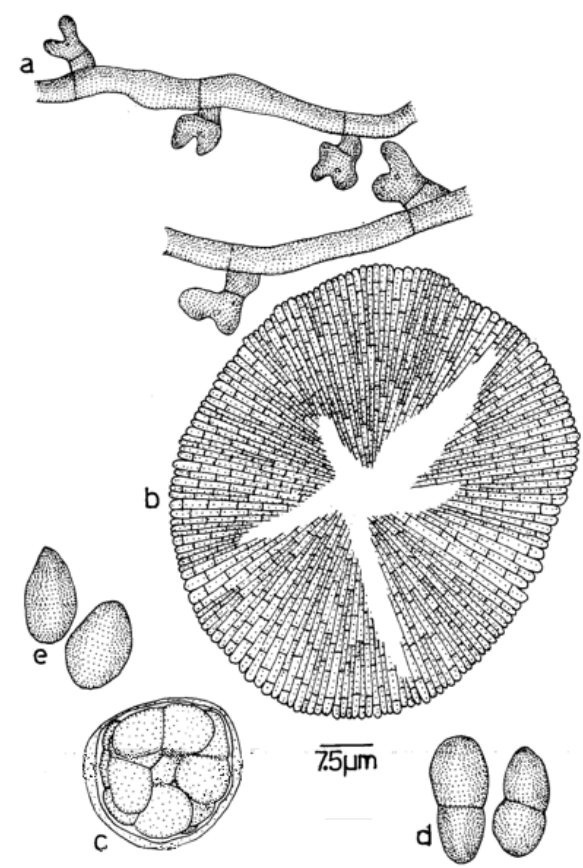
Figure 159. Asterina naraveliae a - Appressorium; b - Thyriothecium; c - Ascus; d - Ascospores